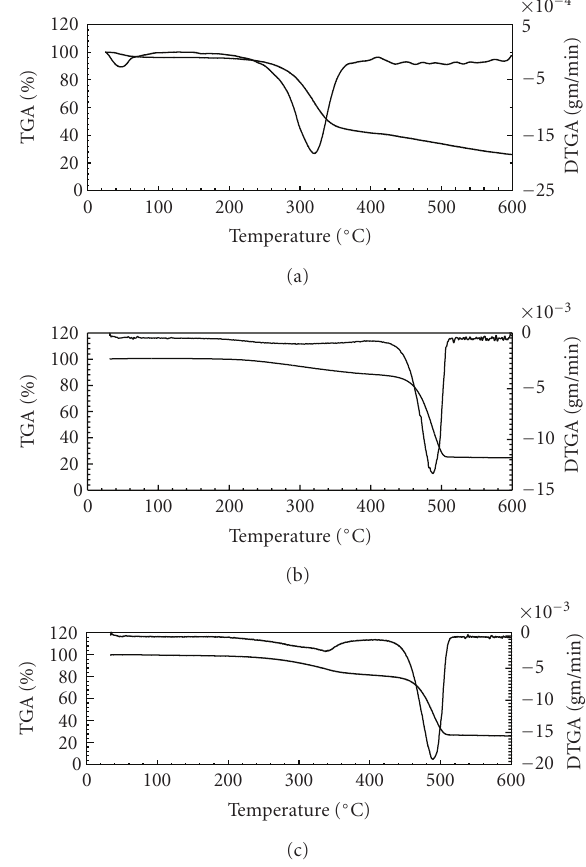
Figure 4: The TGA-DTGA curves of (a) raw WHF, (b) EPDM vulcanizate and (c) sample MW 30